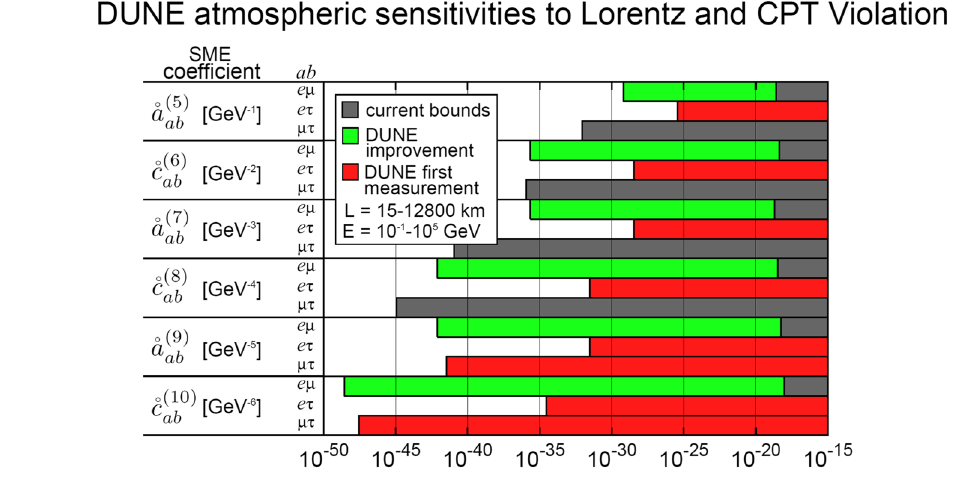
Fig. 8 DUNE atmospheric sensitivities to CPT- and Lorentz-violating nonminimal isotropic SME coefficients. Studies of DUNE atmospheric neutrinos can obtain first measurements (red) on some nonminimal isotropic coefficients and improved results (green) on others. Gray bars display existing limits from the IceCube atmospheric neutrino data [410]. Figure adapted from the DUNE Technical Design Report